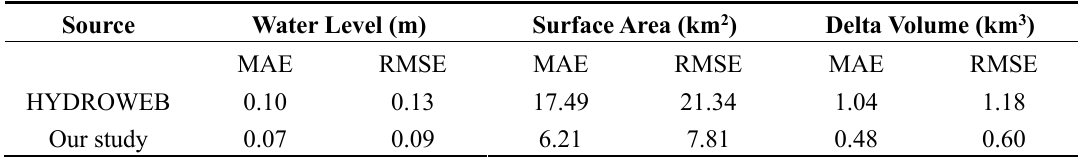
Table 2. Comparison of the accuracy between the results of our study and the data from